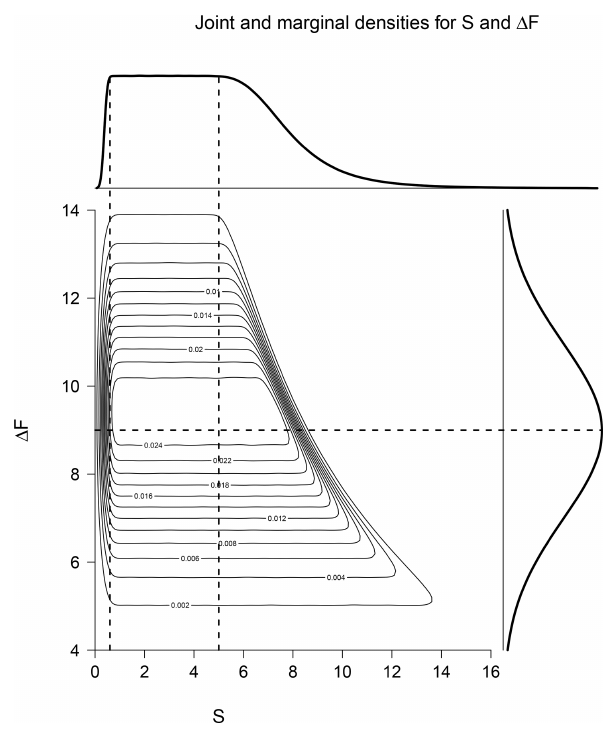
Figure 2. Implicit prior used in the paleoclimate estimate. The con- tour plot shows the joint prior in S and (cid:49)F with marginal densi- ties shown at the top and right, respectively. Vertical and horizontal dashed lines are drawn at S = 0 . 6, 5, and (cid:49)F =